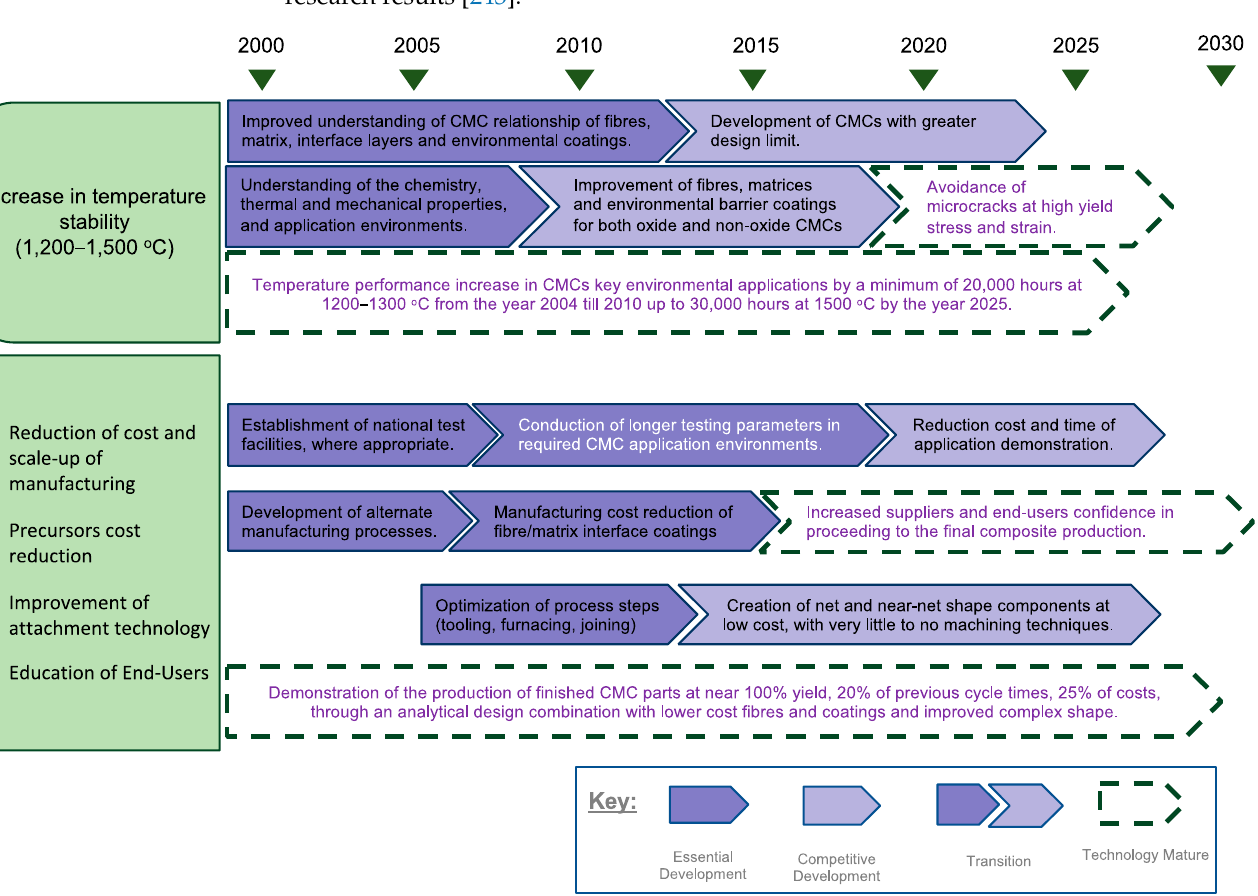
Figure 20. CMC requirements needed to be met for wider